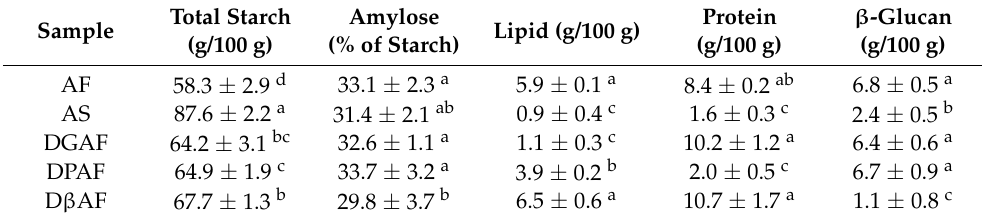
Table 1. Proximate composition of AF and removal of non-starch